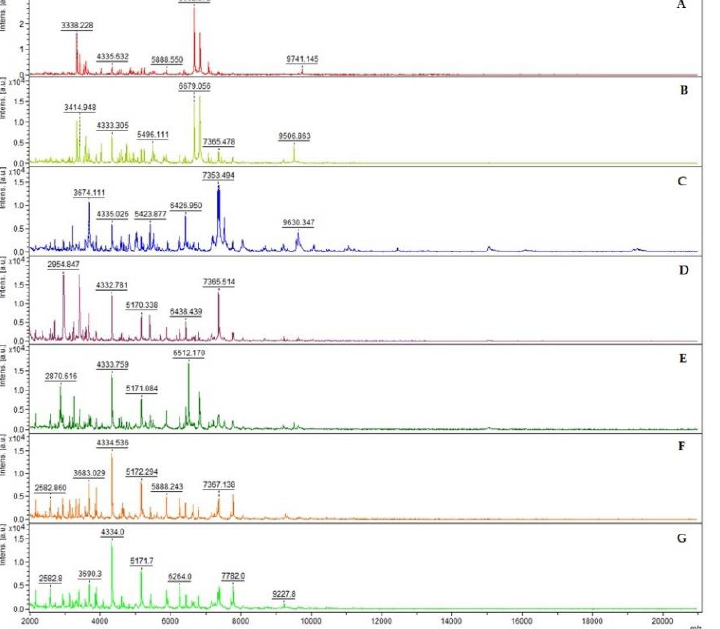
Figure 1. MALDI-TOF mass spectra of seven different Bacillus species in the mass range of 2 to 20 kDa: B. anthracis ( A ), B. cereus ( B ), B. mycoides ( C ), B. thuringiensis ( D ), B. toyonensis ( E ), B. weihenstephanensis ( F ) and B. wiedmannii ( G ). The mass spectra were obtained using the FlexAnalysis software (v. 3.4, Bruker Daltonik GmbH, Bremen, Germany), performing baseline corrected, smoothed and normalized analyses. The mass spectra demonstrate a relatively high signal-to-noise ratio, which typically permits the detection of 50 to 100 mass peaks per spectrum with the signal-to-noise ratio higher than 3.